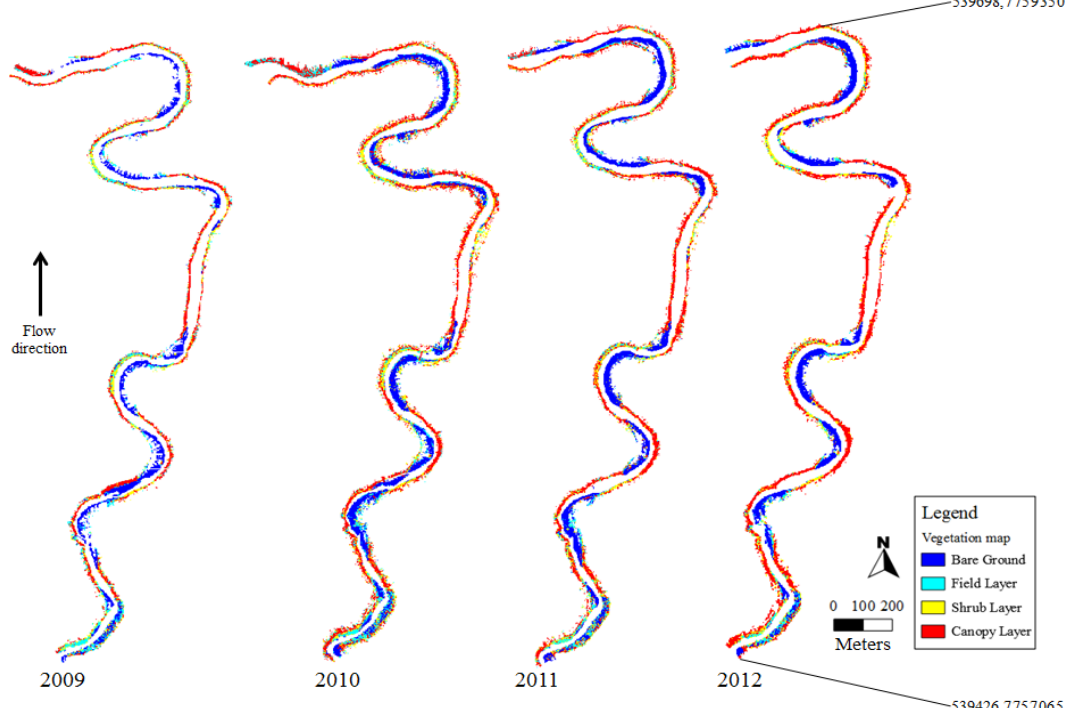
Figure 6. Vegetation estimations for years 2009–2012. Coordinates of the north and south reach of the research area are presented in